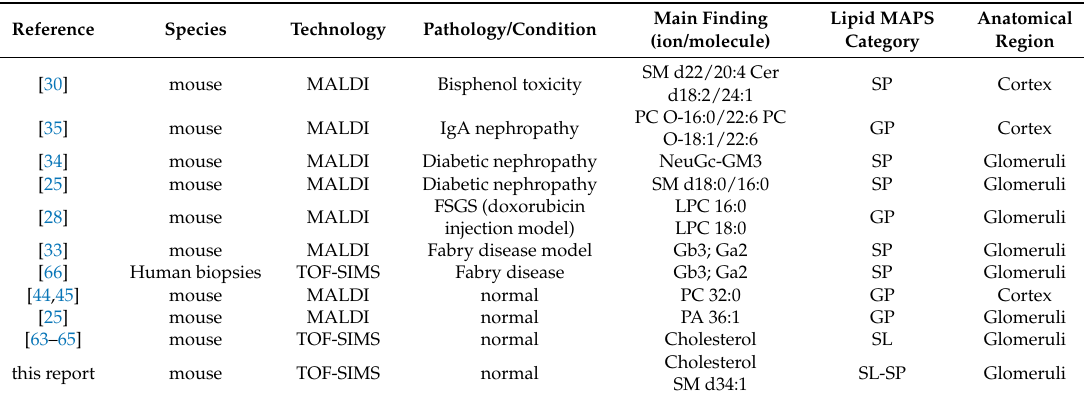
Table 2. Synthesis of reported findings by lipid MSI in renal cortex and glomerular areas.